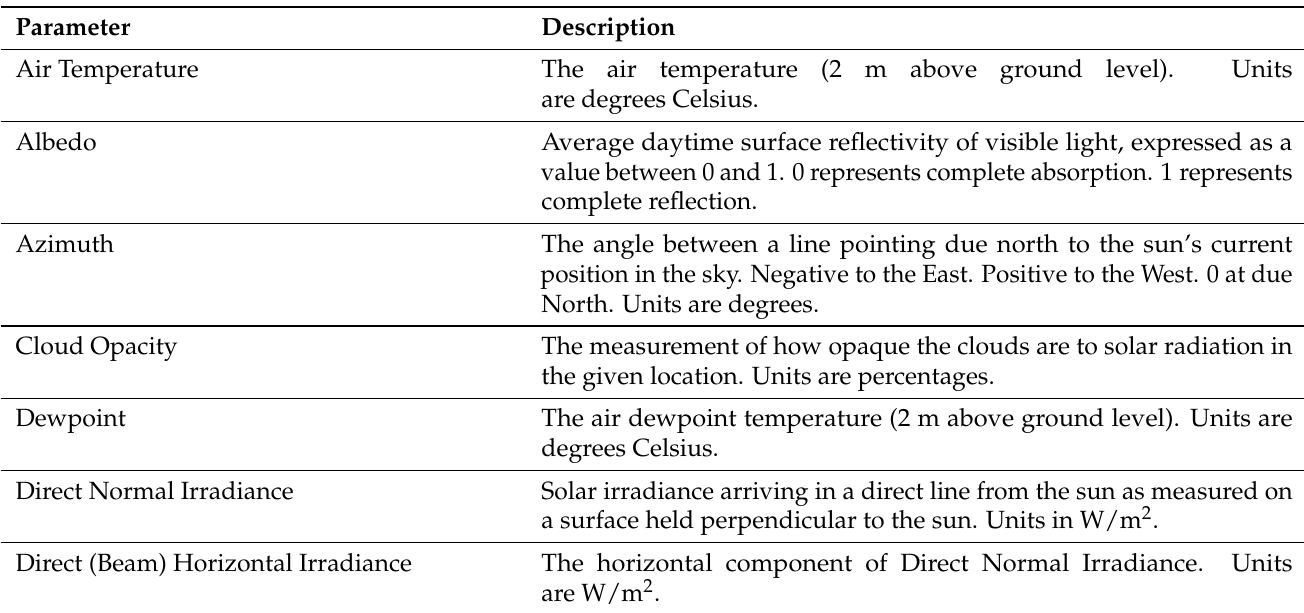
Table 1. List of meteorological parameters available to us from the Solcast